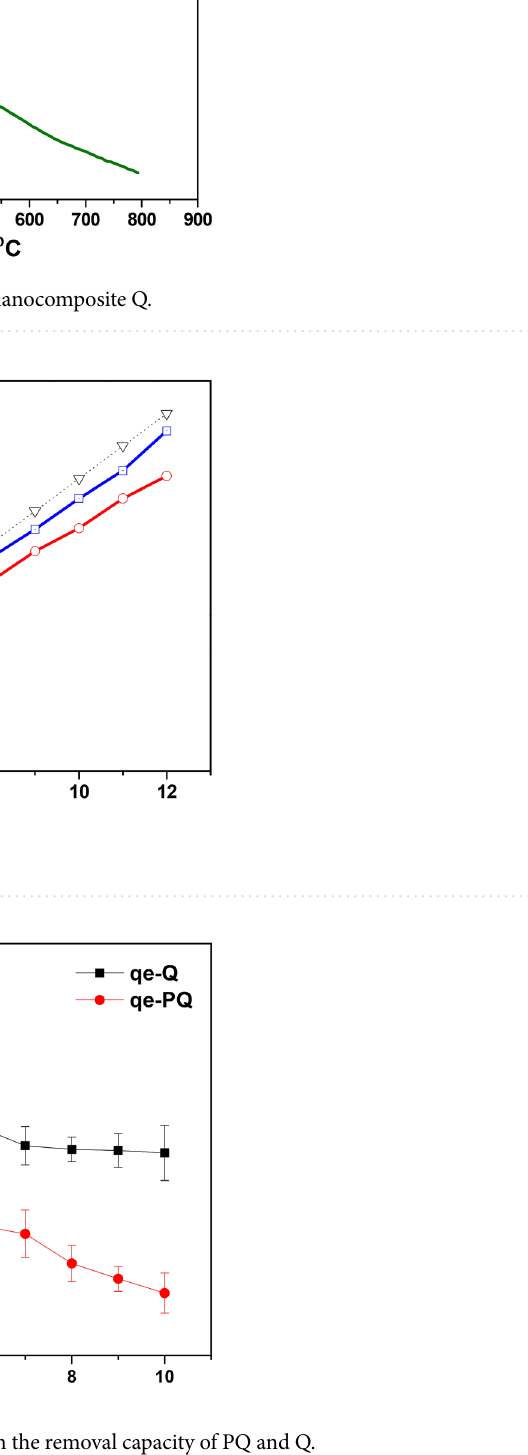
Figure 7. ( a ) The effect of solution pH on the removal capacity of PQ and